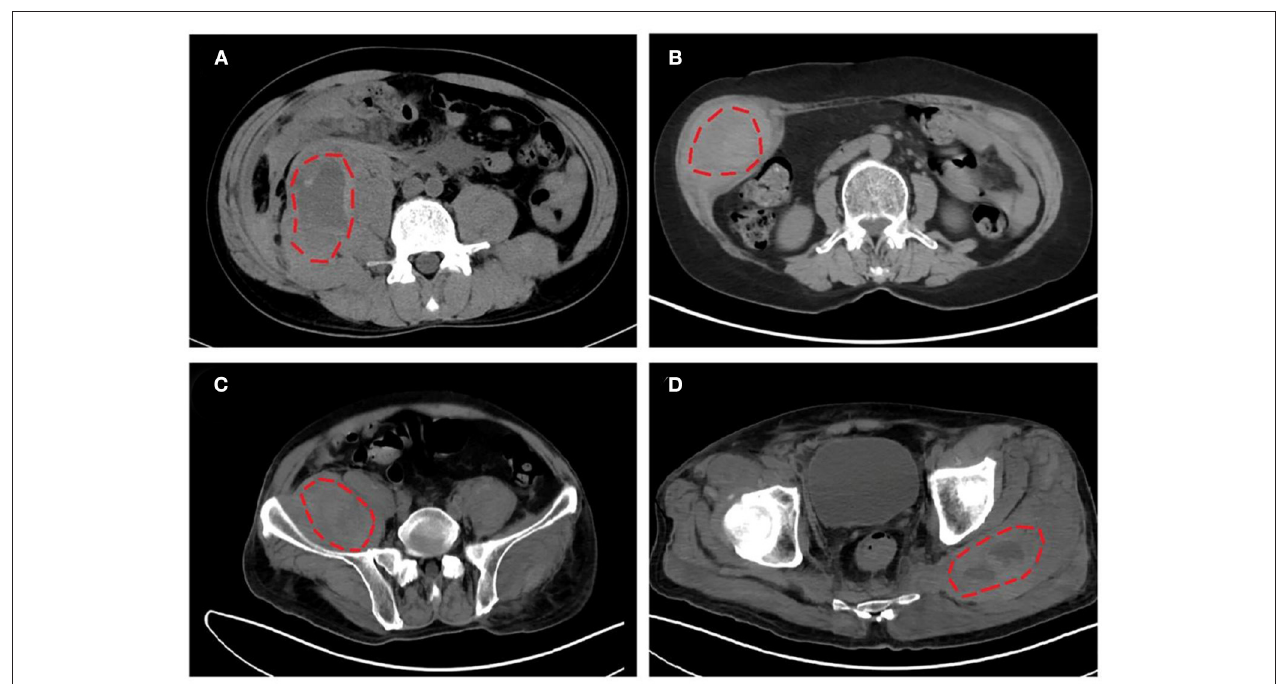
FIGURE 2 | Representative computed tomography (CT) images of intramuscular hematomas in our cases. (A) Hematoma in right iliopsoas and psoas of listed case no. 17. (B) Hematoma in right musculi obliquus internus abdominis of listed case no. 18. (C,D) Hematomas in right iliopsoas and left gluteus maximus of listed case no.